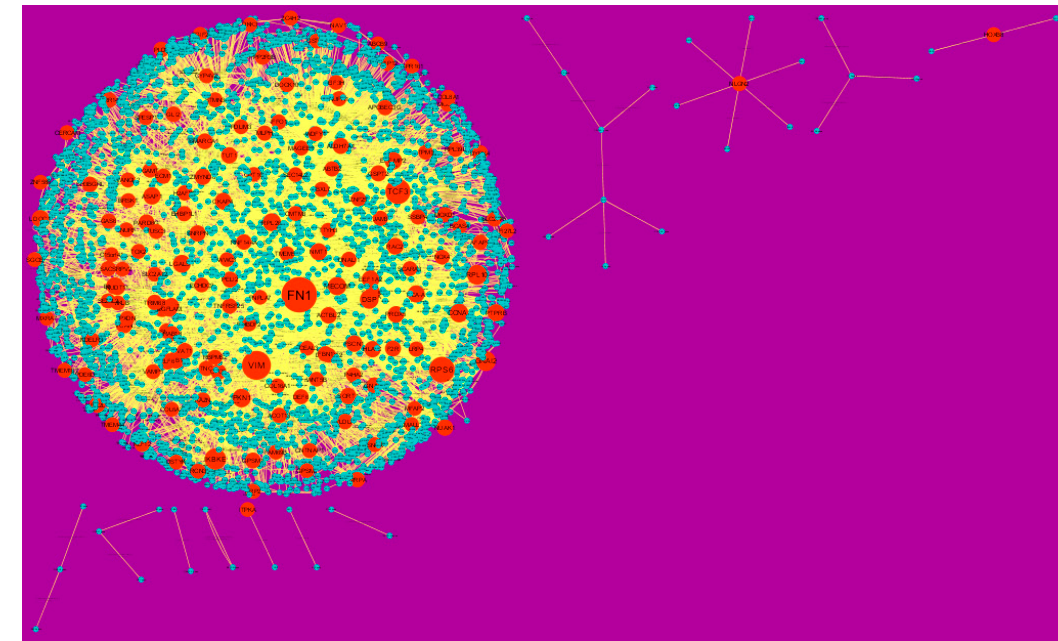
Figure 6. Protein-protein interaction (PPI) networks for differentially-expressed genes (DEGs). (Orange round shape node represents down-regulated genes). Green dots are also genes which are not hub or differential expressed genes. orange rod shape is interaction with adjutant genes.